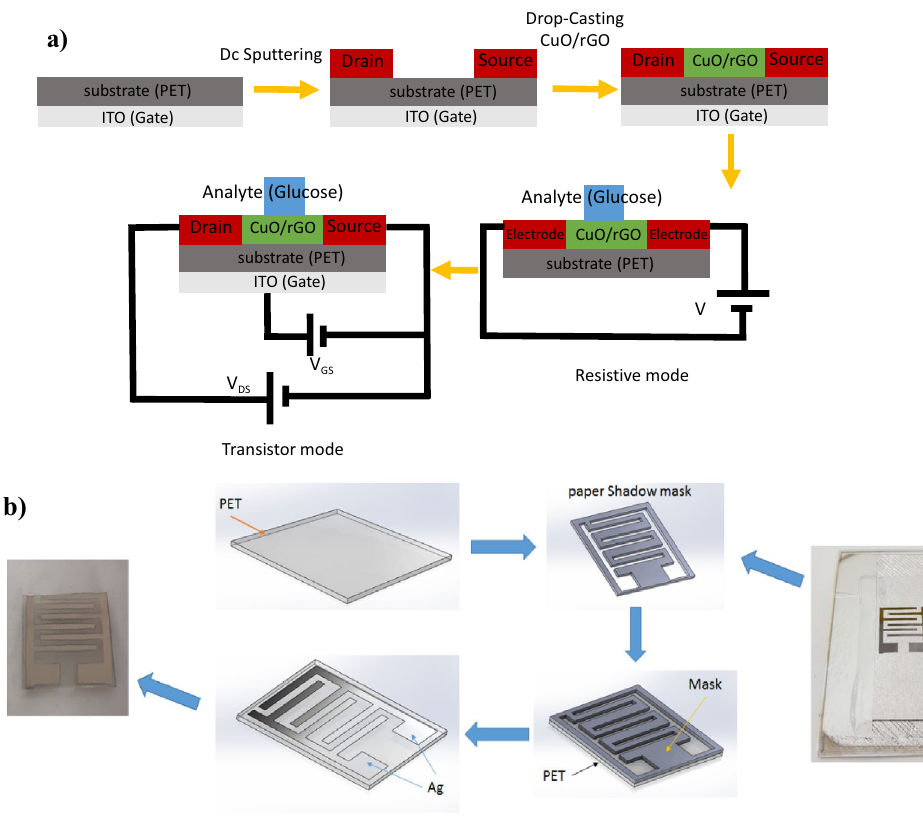
Figure 3. ( a ) Schematic of the fabrication process of the rGO/CuO-NHS BGFET sensor for glucose detection in both resistive and transistor modes. ( b ) Steps of fabricating the silver interdigitated electrodes on the PET substrate with a shadow mask.